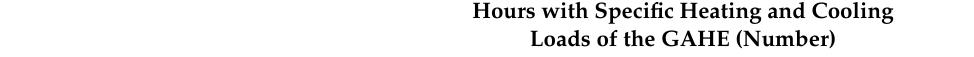
Table 2. Distribution of hourly heating and cooling loads of the GAHE